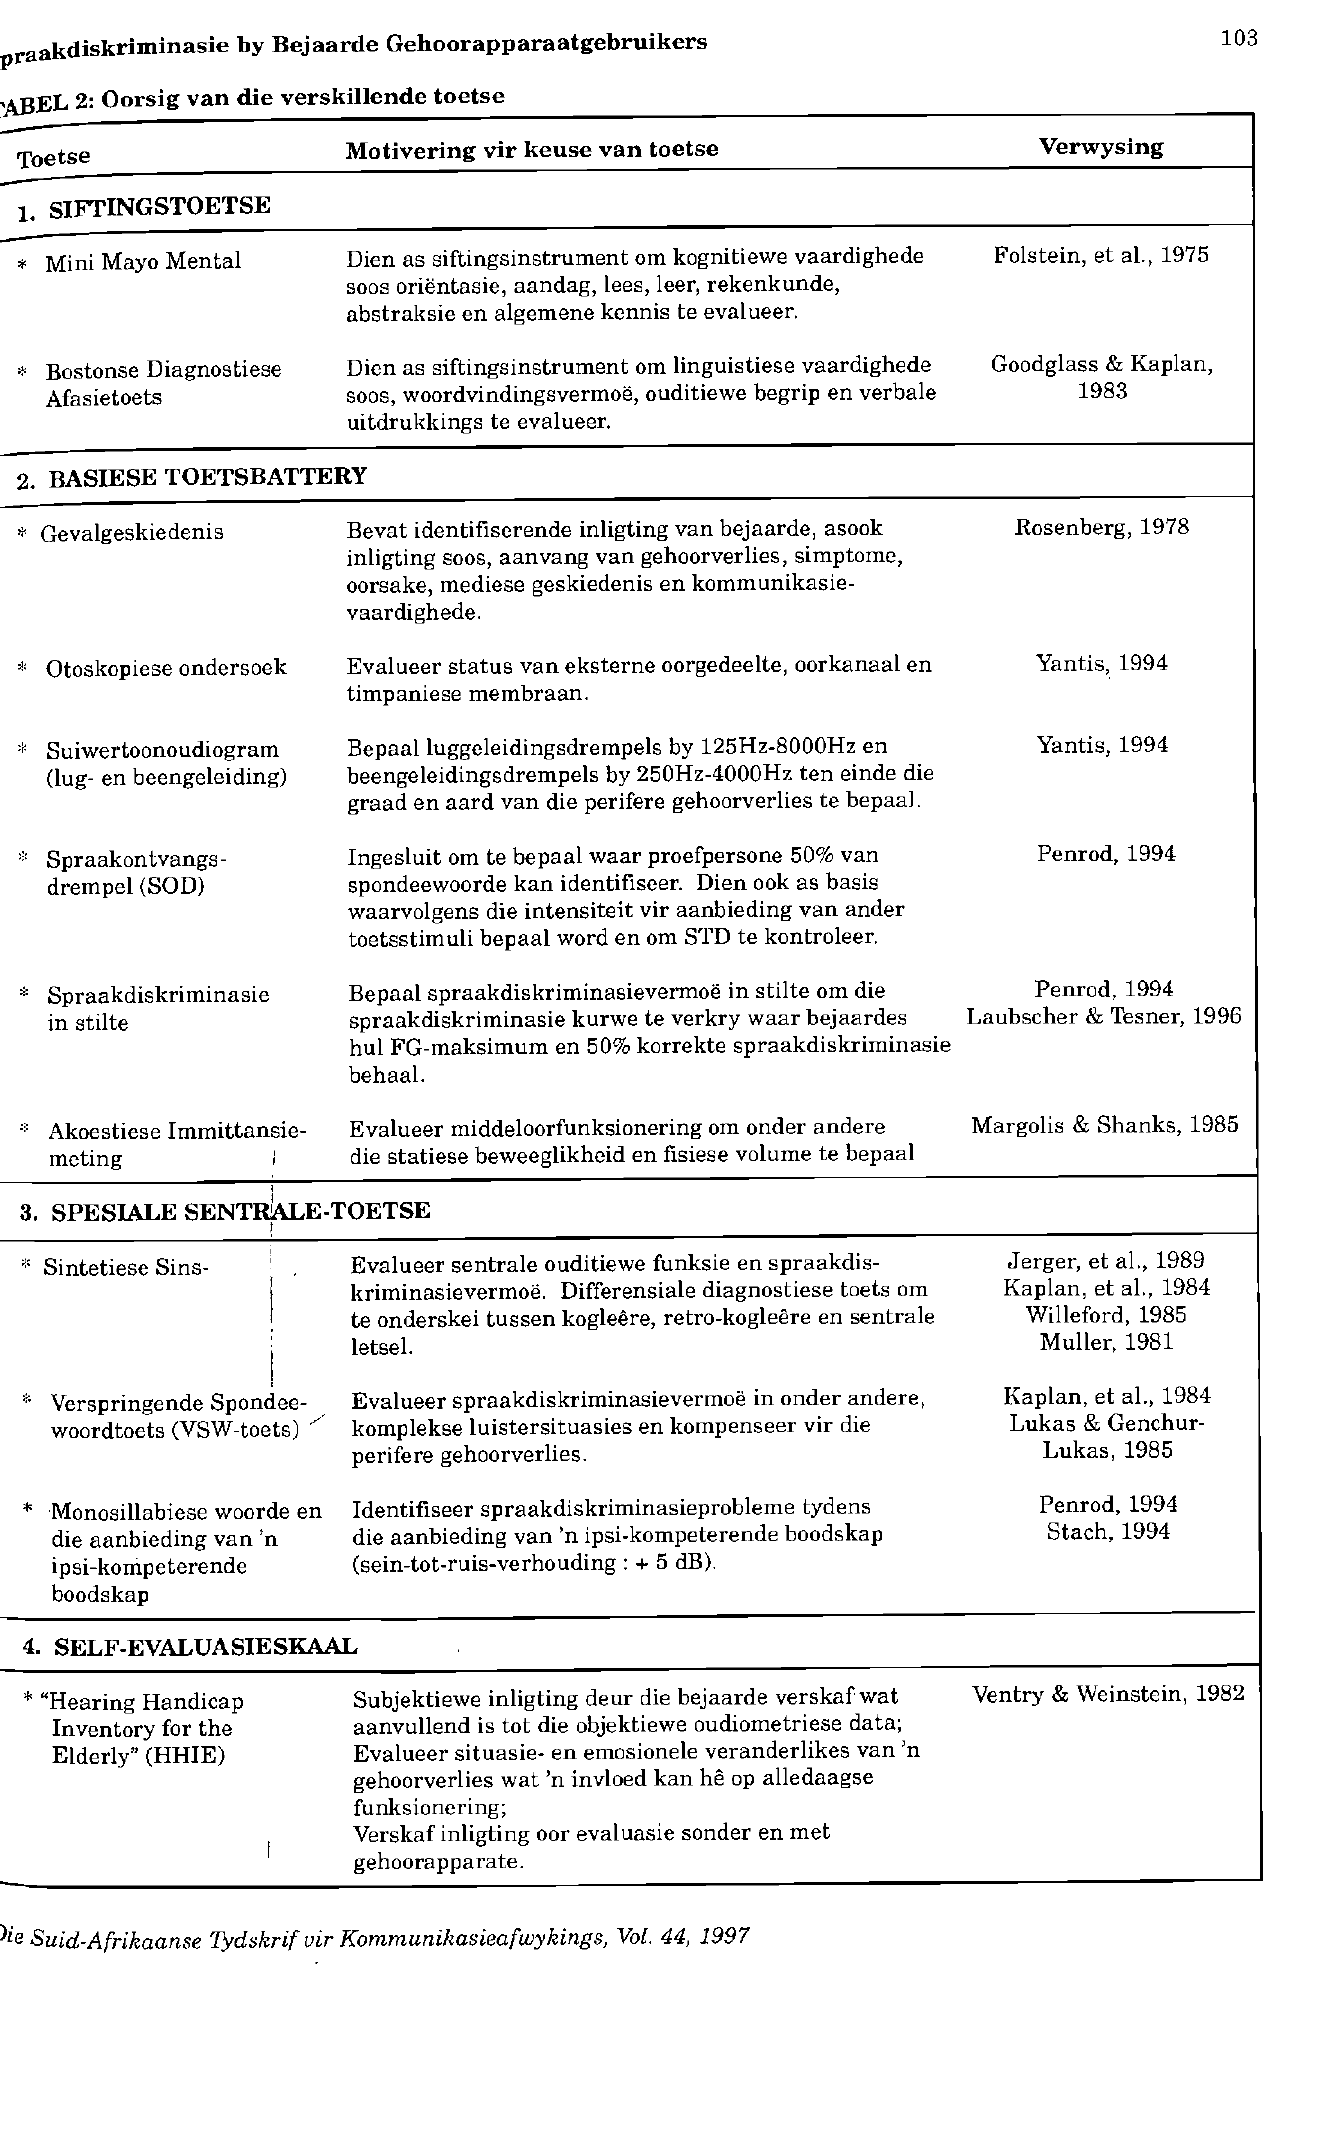
TABEL 2: Oorsig van die verskillende toetse